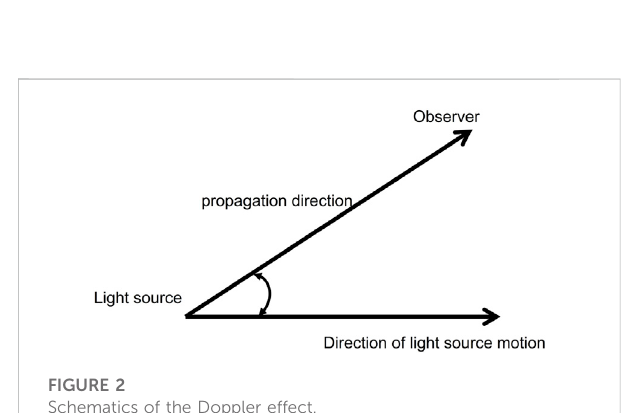
FIGURE 2 Schematics of the Doppler